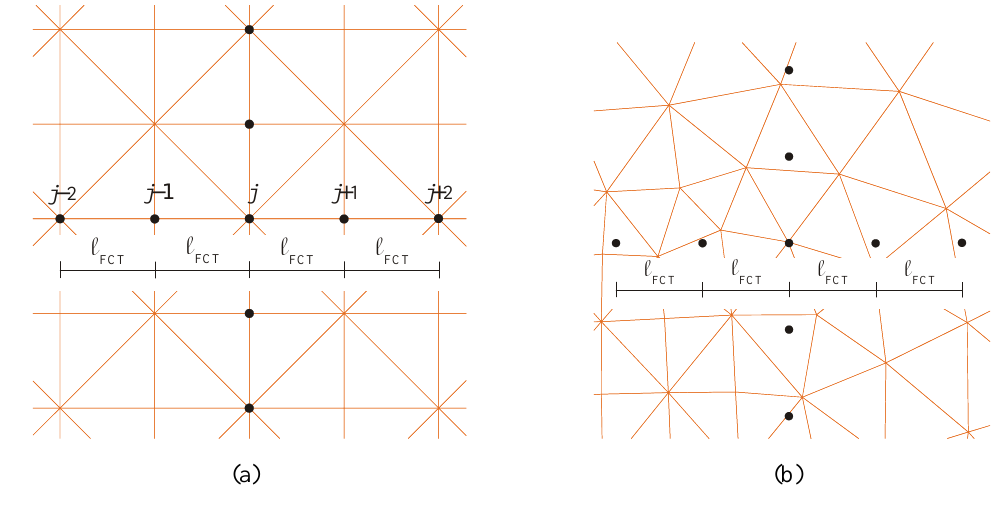
Figure 2. Deployment of points for the computation of FCT diffusive/antidiffusive